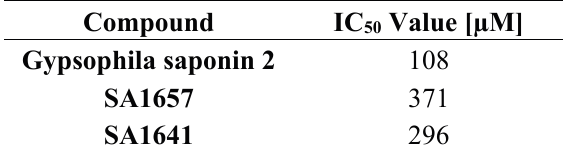
Table 1. Effect of saponin derivatives on the activity of surface displayed Hyal-1.